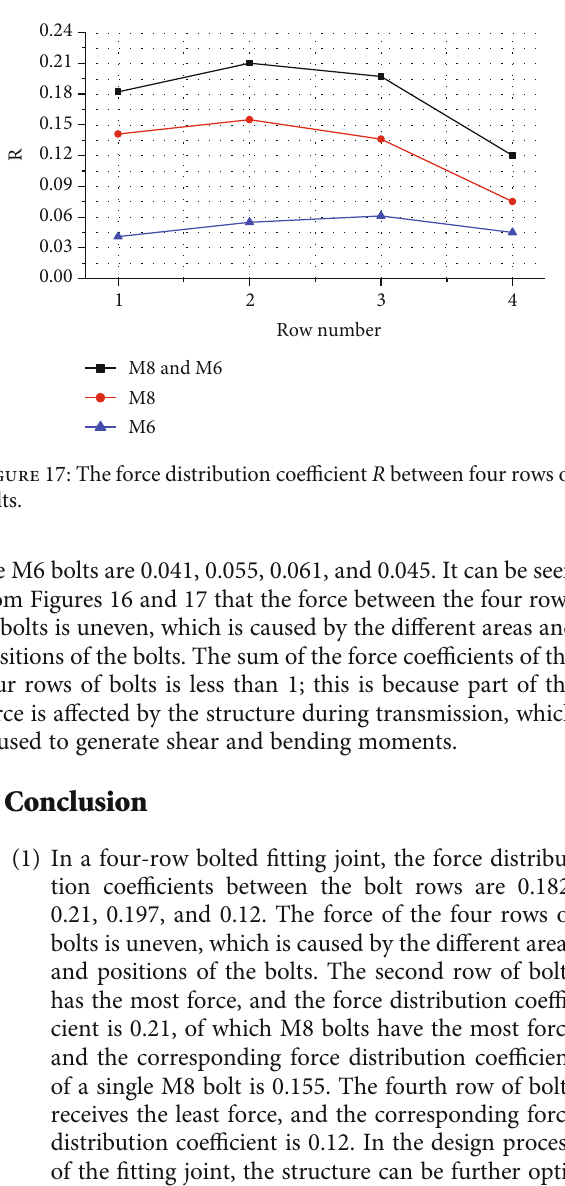
Figure 16: The force distribution between four rows of bolts.